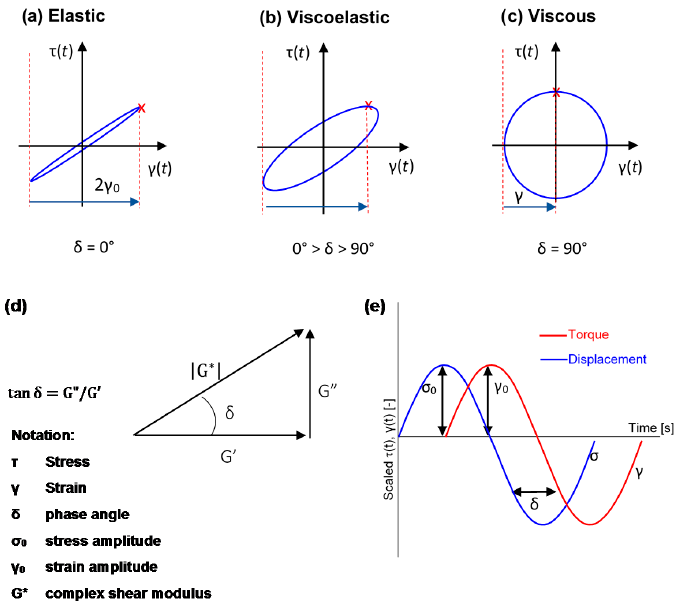
Figure 4. Elastic Lissajous–Bowditch representations (stress plotted against strain) of three ideal material responses, ( a ) the point of greatest stress occurs at 2 γ 0 after the previous strain reversal; ( b ) linear viscoelastic response (center) has the stress maximum somewhere intermediate to these limits;